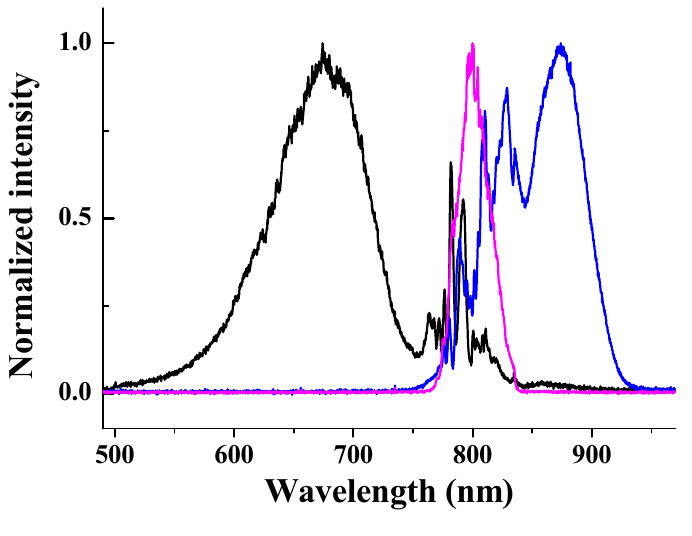
Figure 22. The spectra of beam2 (magenta line) and beam1 with an LPF with cut-off wavelength around 850 nm (blue line) or a SPF with the cut-off wavelength at 820 nm (black line) [34].